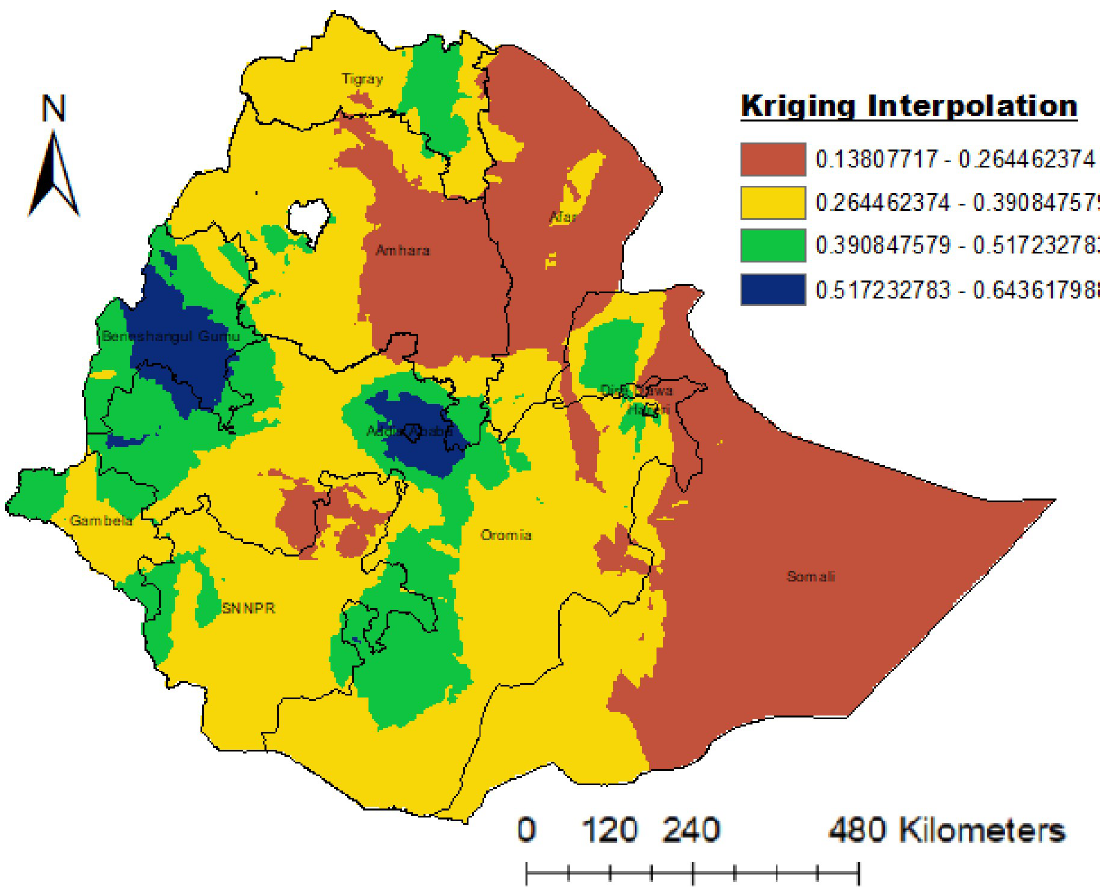
Fig 5. Kriging interpolation of unemployment women in Ethiopia,2016 EDHS (Source of shapefiles: https://africaopendata.org/ dataset/ethiopia-shapefiles).